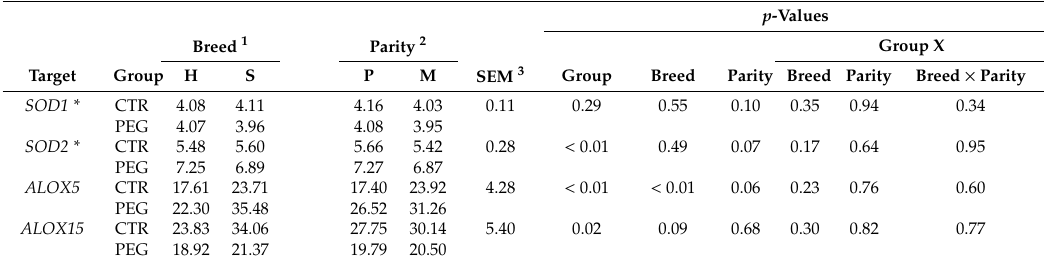
Table 5. LSM ± SEM of arbitrary mRNA abundance for genes related to oxidative stress in whole blood leukocytes evaluated 3 days after calving from Simmental and Holstein cows treated with pegbovigrastim (PEG) or with saline (CTR) at approximately Day 7 relative to calving and within 24 h the day of calving. p -Values Breed 1 Parity 2 Group X Target Group H S P M SEM 3 Group Breed Parity Breed Parity Breed × Parity SOD1 * CTR